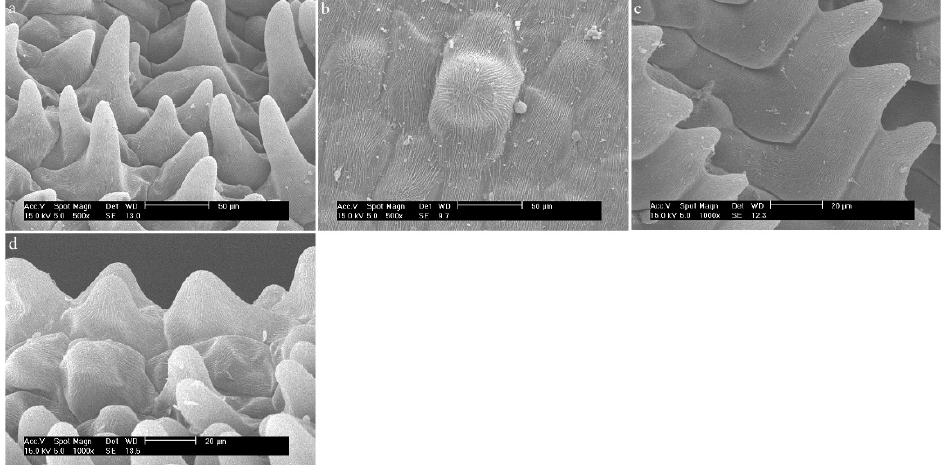
Figure 3. The types of papillae found on the labella of the Dendrobium species: ( a ) cylindrical and conical; ( b ) semicircular; ( c ) conical; ( d ) conical with rounded or pointed apices.